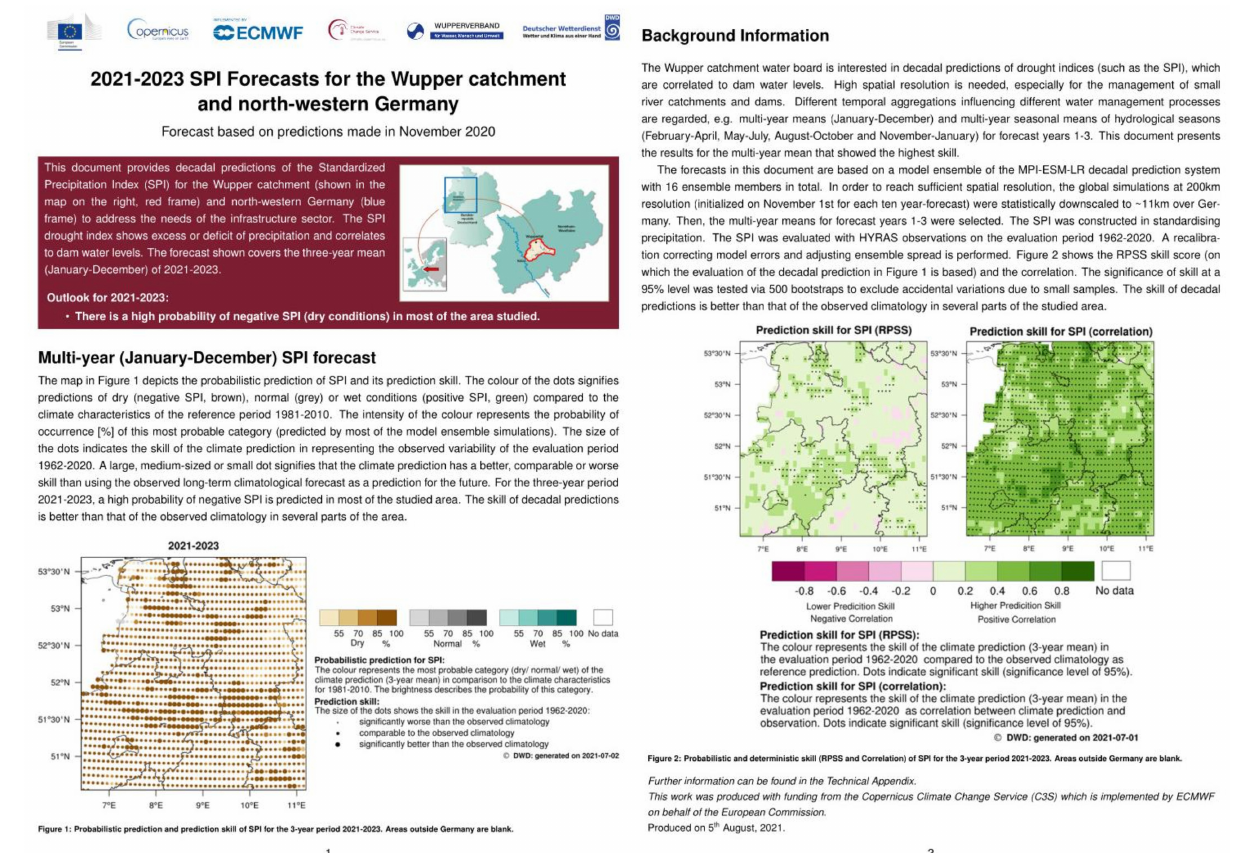
FIGURE 8 | C3S product sheet on decadal predictions for infrastructure: 2021–2023 SPI forecasts for the Wupper catchment and north-western Germany, started in November 2020 (published on